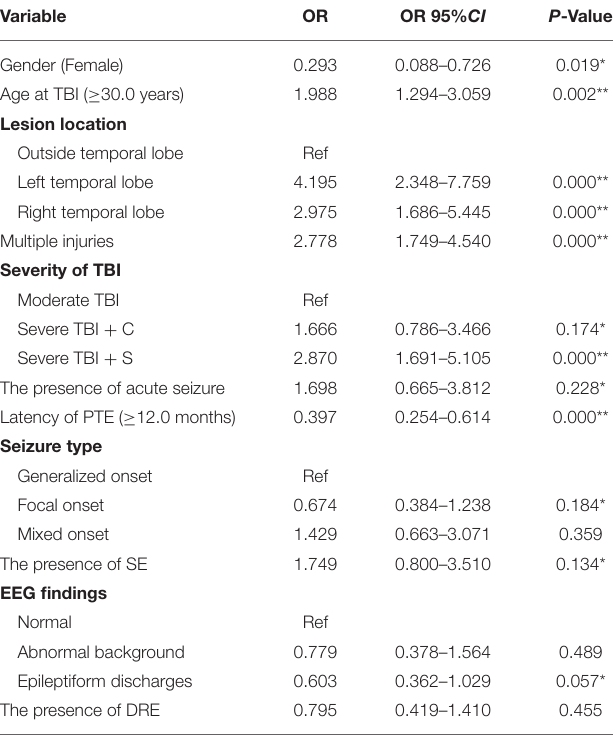
TABLE 2 | Univariate logistic regression of unfavorable 5-year global functional outcomes.